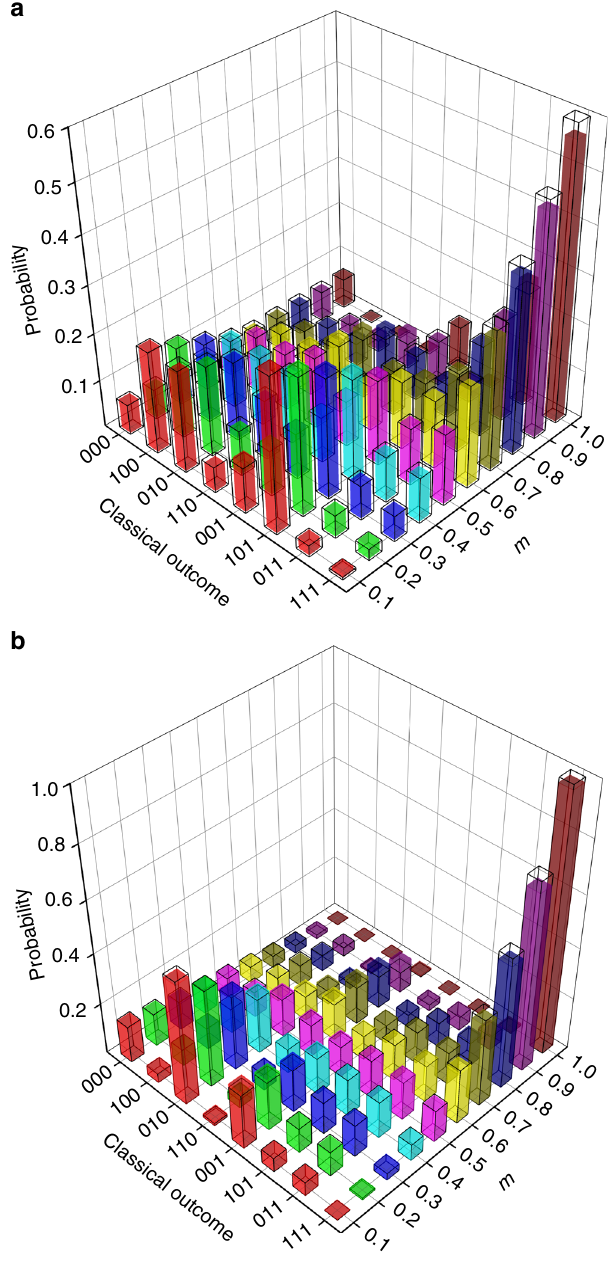
Fig. 4 Sampling of statistical futures. a The coloured bars show the measured probability of different outcomes for the three simulation steps, when the initial state is | S 0 〉 with l = 0.4, and for discrete values of m in the range 0.1 – 1.0. The transparent bars show the theoretically calculated probabilities for the corresponding process. b The sampled future of the same process, when the initial state is | S 1 〉 . Uncertainties, due to the Poissonian distribution of photon counts, are so small that they are not visible in the graphs — therefore, they are not depicted. Note that the classical probability distribution is determined by the process parameters l and m , as well as the initial causal state. For example, if the last outcome of the coin is 1, the quantum simulator is initialised in state | S 1 〉 . The conditional probability of subsequently observing 111 is then m 3 . For a fi xed l = 0.4 and increasing m , the average probability of getting 1 in the simulation thus rises accordingly. This can be seen by the higher columns in the right corners of both